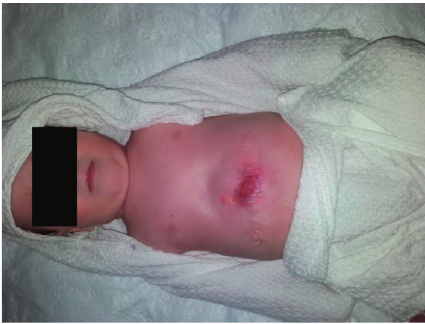
Figure 5: The wound at the time of discharge from the hospital. The abdominal wall was closed with only a small skin defect covered by